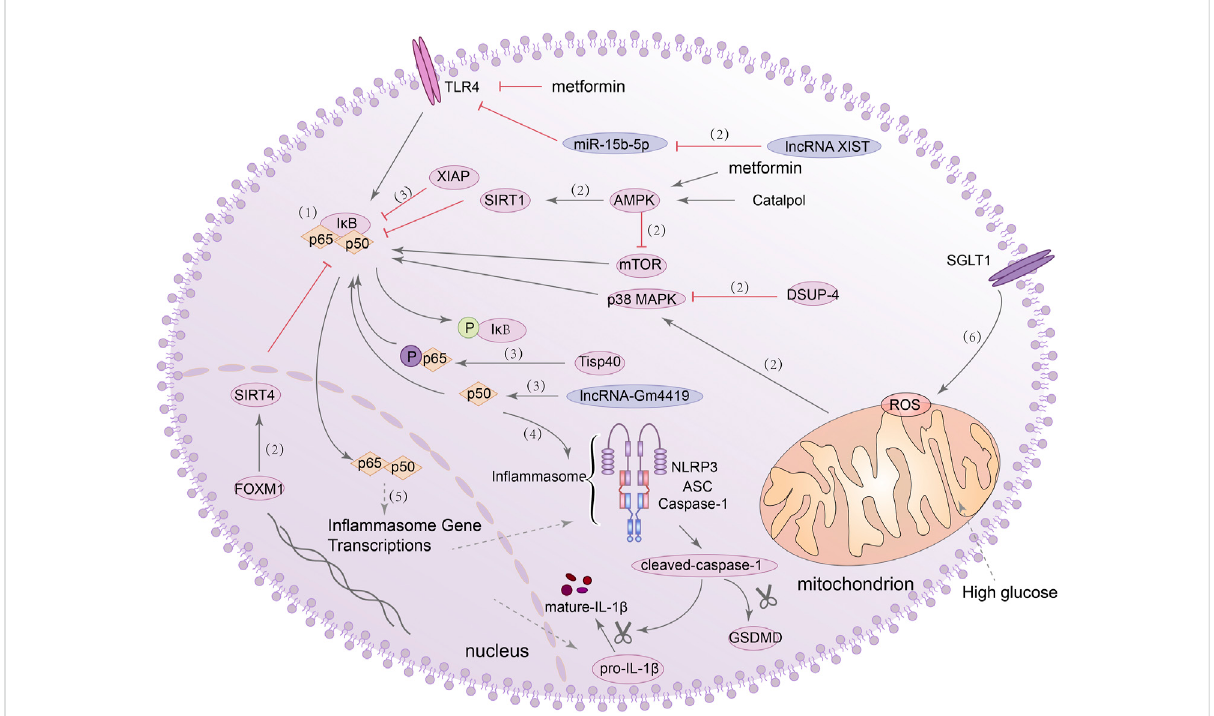
FIGURE 2 NF- κ B/NLRP3 signaling pathway is involved in the regulation of pyroptosis. (1) NF- κ Bbinds with I κ B in inactive form, dissociates the active form of P50/P65 heterodimer upon stimulation. (2) lncRNA XIST/miR-15b-5p/TLR4/NF- κ B signaling pathway, AMPK/SIRT1/NF- κ B signaling pathway, AMPK/mTOR/NF- κ B signaling pathway, DSUP-4/MAPK/NF- κ B signaling pathway, ROS/MAPK signaling pathway and FOXM1/SIRT4/NF- κ B signaling pathway, theyall can regulatetheactivationof NF- κ B. (3)Tisp40 andlncRNA-Gm4419 canpromotetheactivation ofNF- κ Bp65/p50,and XIAP can inhibit the activation of NF- κ B. (4) P50 can act with NLRP3 in fl ammasome and lead to increased expression of pro-in fl ammatory cytokines and GSDMD-N.(5) NF- κ Bcan promote thetranscriptionofin fl ammasome genes.(6) Knockdownof SGLT1 partially reduced pyroptosis,ROS generation and NF- κ B